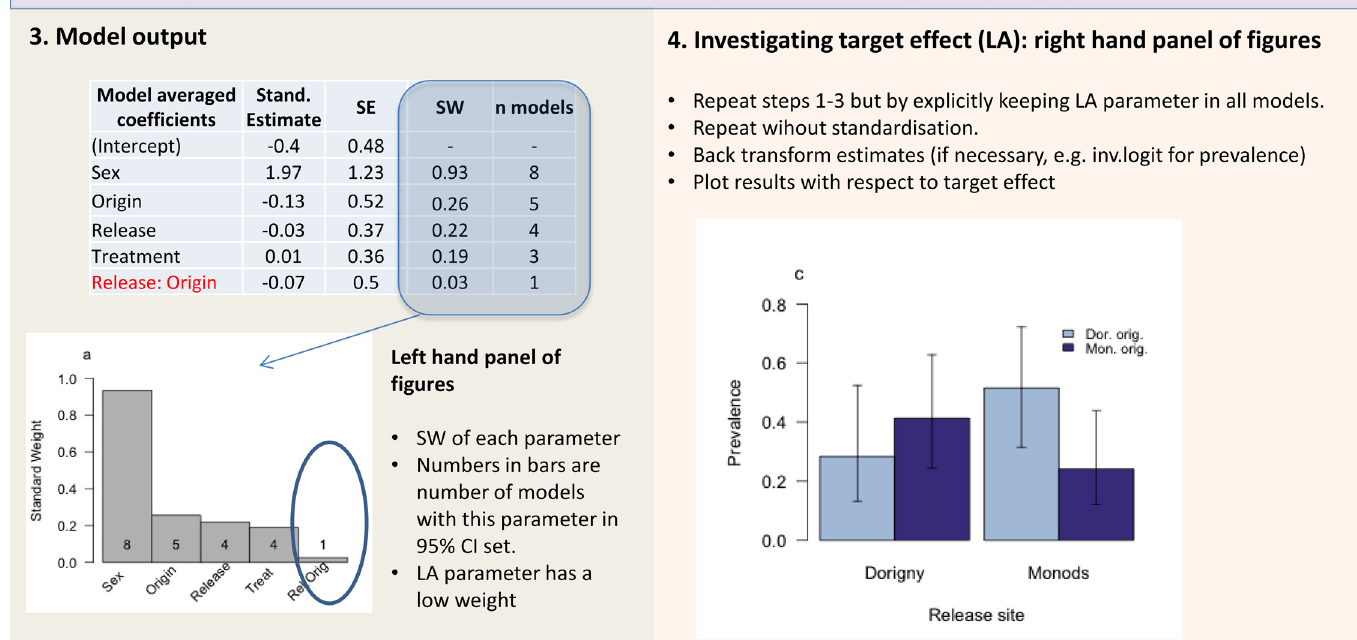
Fig 1. A step-by-step guide to the statistical modelling and the model selection and averaging procedure implemented (modified from